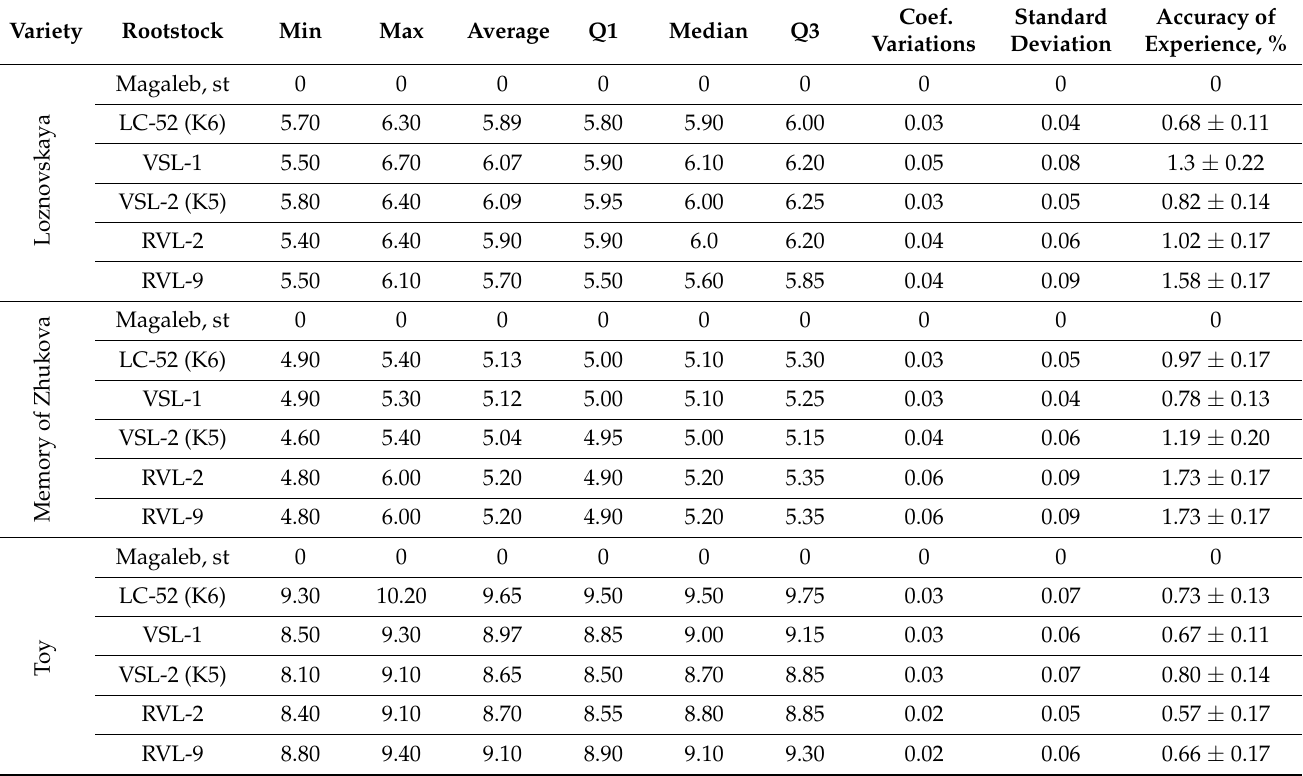
Table 6. Statistical indicators of fruit weight of variety − rootstock combinations of cherries (average for